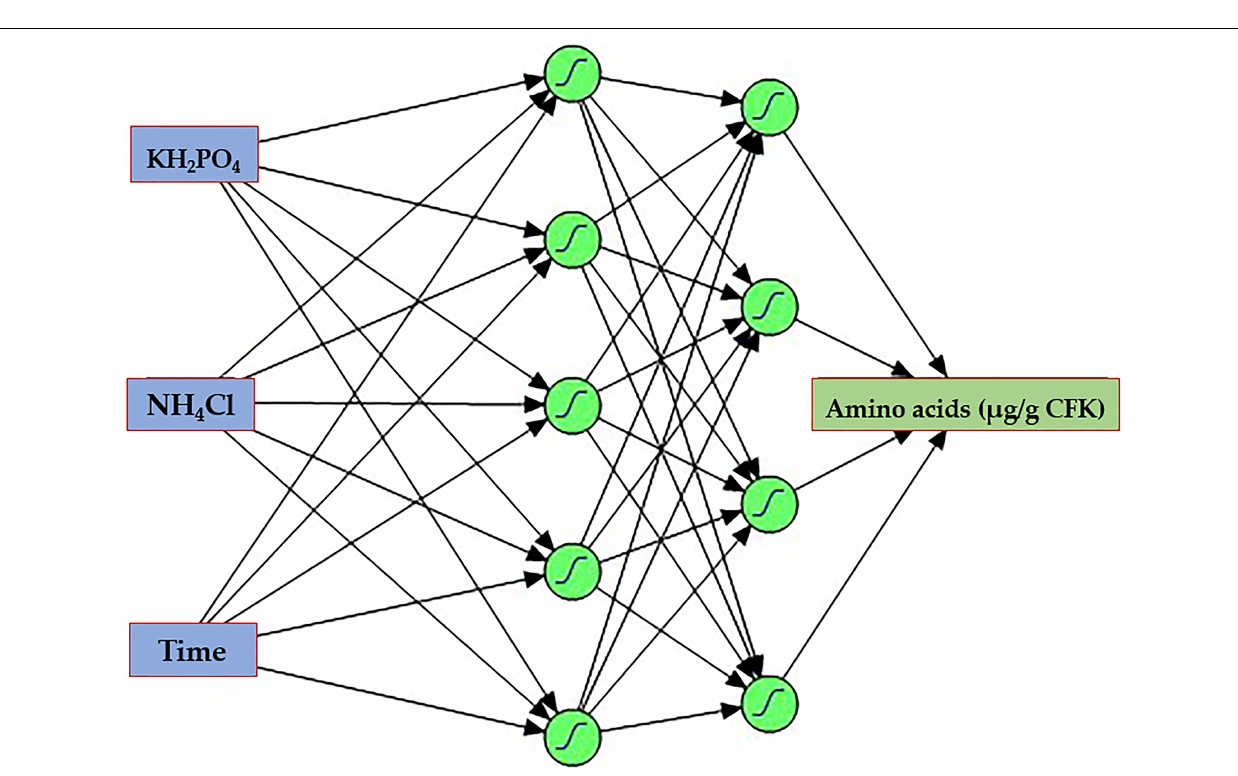
FIGURE 7 | Contour plots show the interactive effects of each pair of the independent variables on amino acids production by B. paramycoides ZW-5, holding the third variable at the center point. Hold values are 0.55 mg for KH 2 PO 4 , 1.5 mg for NH 4 Cl, and 10.5 days for incubation time.